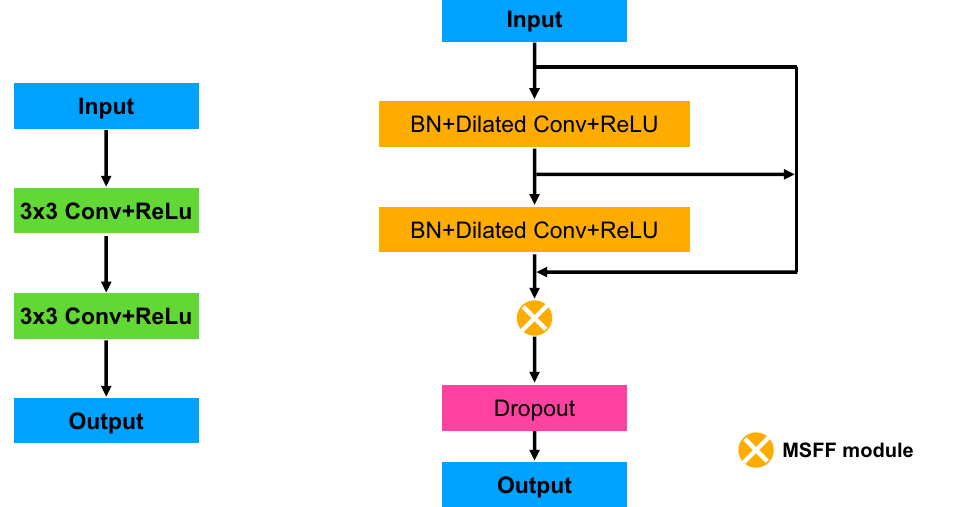
Figure 5. The architecture of multiscale feature capture block (MSFCB).